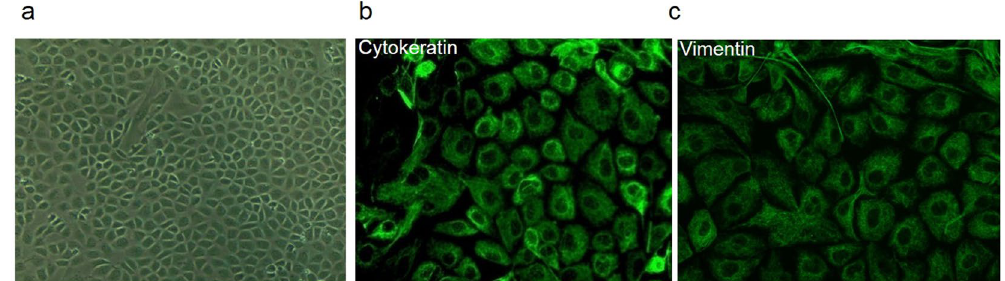
Figure 2. Identification of rat peritoneal mesothelial cells (RPMCs). ( a ) Primarily cultured peritoneal mesothelial cells exhibited cobble-like appearance under light microscope. ( b , c ) Cellular immunofluorescence staining revealed that cytokeratin and vimentin were positive in primarily cultured RPMCs. Original magnification ×